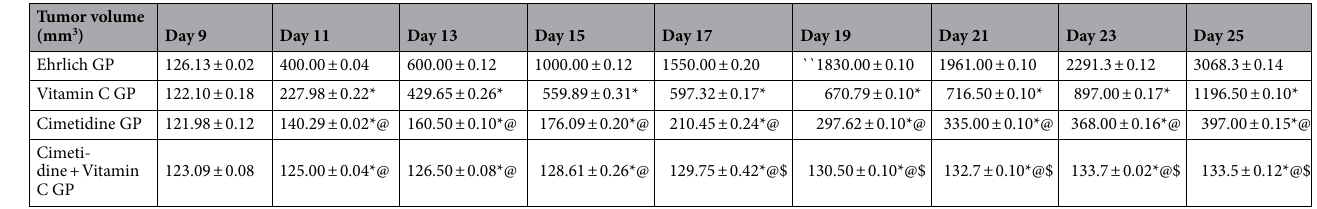
Table 4. Effect of Cimetidine, Vitamin C, and their combination on tumor volume estimated by Vernier caliper in the mammary fat pad of mice in different groups. Significantly different from untreated group, *P < 0.05. Significantly different from vitamin C-treated group, @ P < 0.05. Significantly different from cimetidine-treated group, $ P < 0.05. @ Data are presented as mean ± SD.